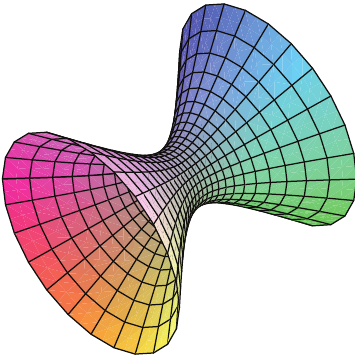
Figure 6: The de Sitter